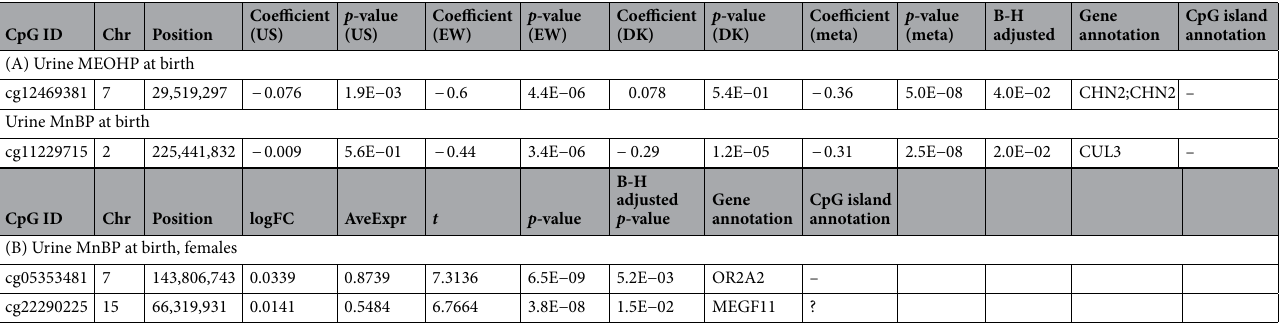
Table 2. Results of the epigenome-wide association studies (EWAS). (A) CpG sites associated with birth urine MEOHP and MnBP concentration variables with gene and CpG island annotation. (B) Sex-specific results